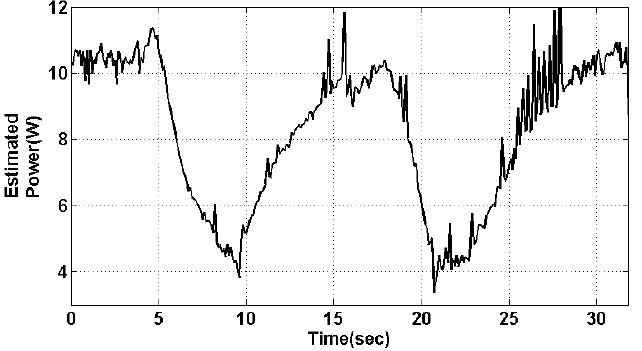
Figure 27. Estimated power received by the load coil of the experimental vehicle during the second experiment.